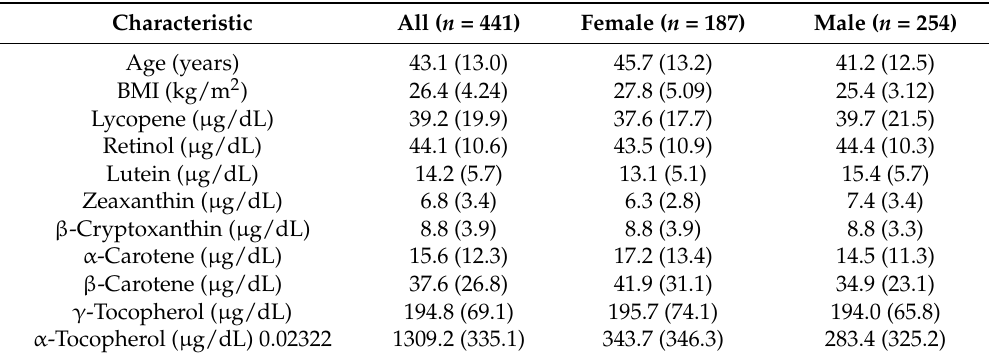
Table 1. Characteristics of Old Order Amish study sample from Lancaster County, Pennsylvania after consuming a 6-day controlled